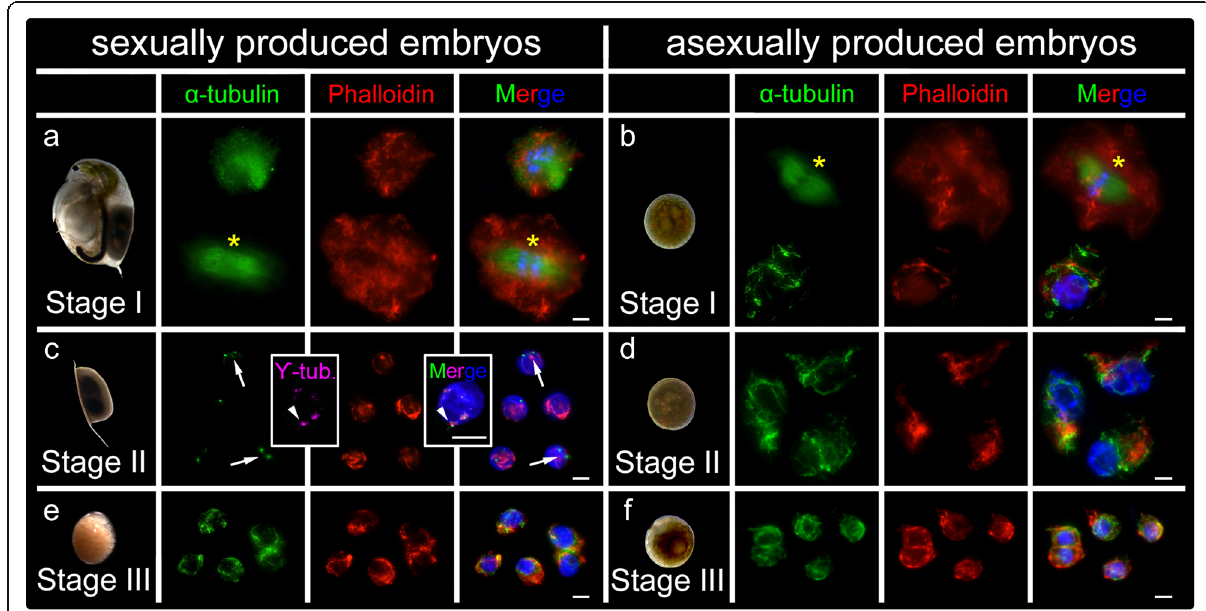
Fig. 3 Cytoskeletal changes in cells of sexually and asexually produced embryos of Daphnia magna . Double immunolabelling of α -tubulin (green) as marker for microtubules, and Phalloidin (red) as marker for actin filaments, counterstaining of the chromatin with DAPI (blue). a α -tubulin and Phalloidin were found in sexually produced embryos and b in asexually produced embryos. An interphase and an anaphase (asterisk) are shown in ( a ) whereas an interphase and a metaphase (asterisk) are shown in ( b) . c In cells of diapausing embryos, polymerized microtubules were nearly absent. Only two small green dots (white arrows) are observable; double immunolabelling of α - tubulin (green) is overlaid with pericentriolar material marker γ -tubulin (pink), presumably corresponding with the centrosome localization. Although nucleus size remains constant, actin networks display a significantly reduced cytoplasm during diapause. d In asexual embryos no difference between cytoskeletal architecture was observed between stage I and stage II organisms ( e ) in resuscitated D. magna sexually produced embryos, cytoskeletal features reappear at stage III accompanied with the onset of cell division. Polymerization of microtubules is visible and actin networks increase in complexity indicating cytoplasmatic growth. f Cytoskeleton is continuously expressed in stage III asexually produced embryos. Scale bars: 10 μ